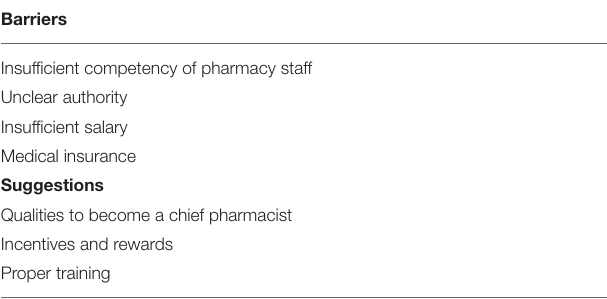
TABLE 2 | Key barriers and suggestions for implementation of Chief Pharmacist System.